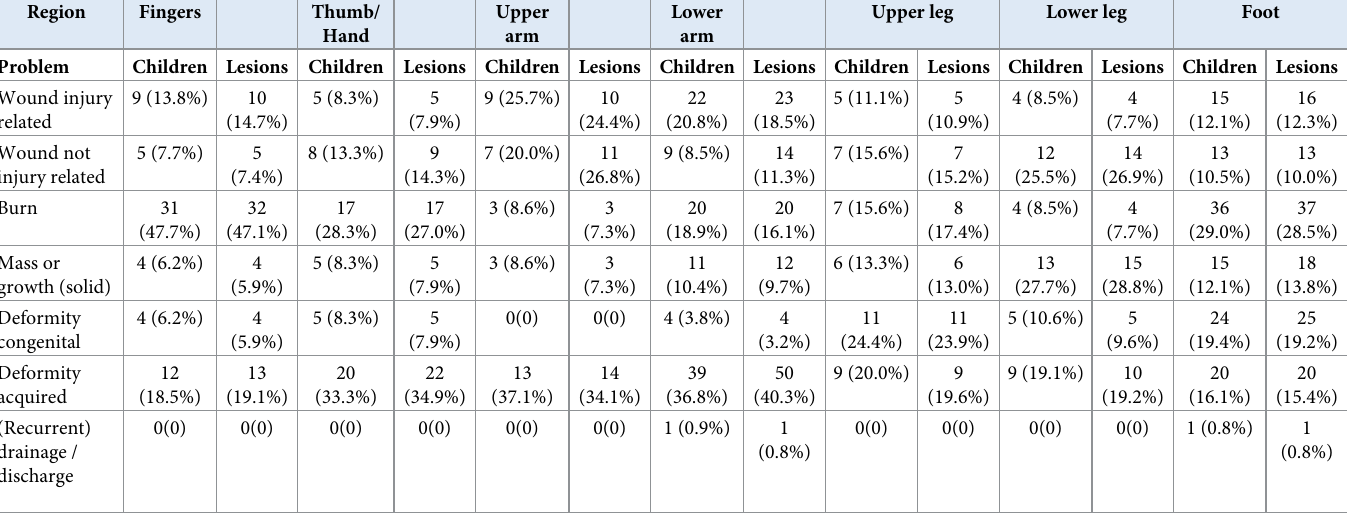
Table 5. Lesions on